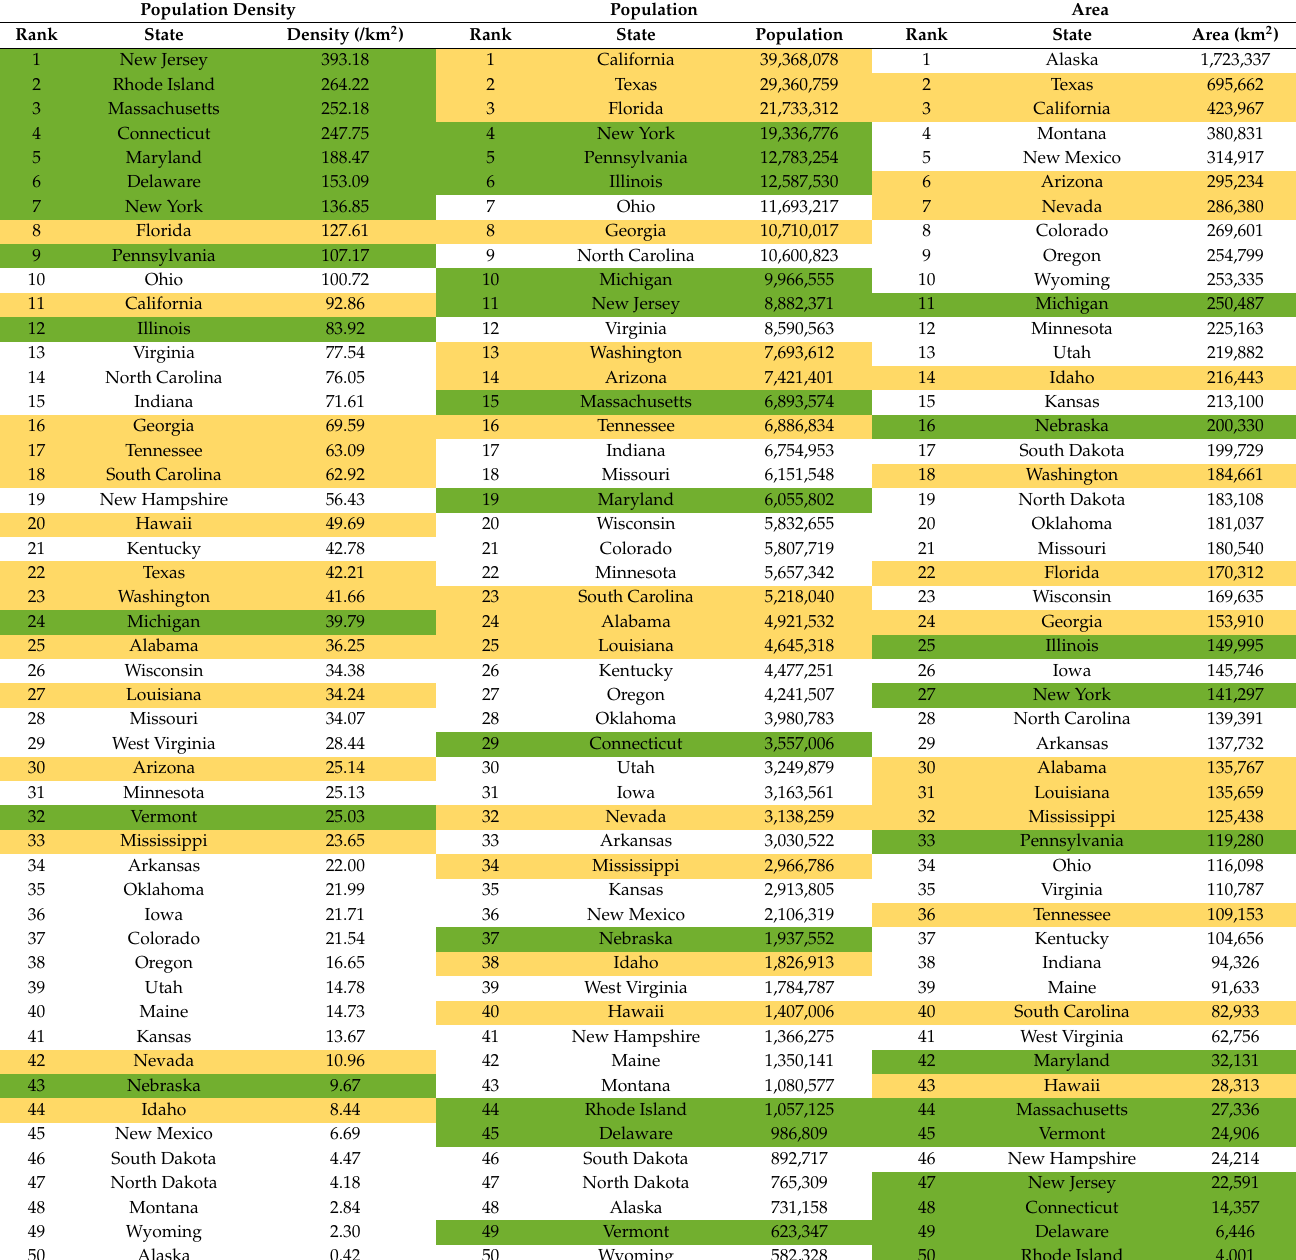
Table 1. The ranked lists of the 50 states in the US according to their population densities, populations, and areas, where the states with two epidemic outbreaks occurring in March–April and October–January are highlighted in green, those with two epidemic outbreaks occurring in June–August and October–January are highlighted in yellow, and those with only one epidemic outbreak occurring in October–January are not